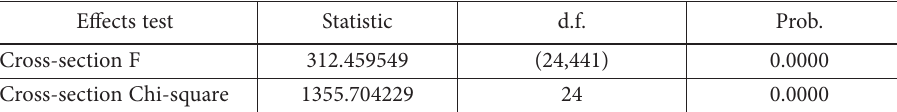
Table 7. Summary of the Redundant Fixed Effects